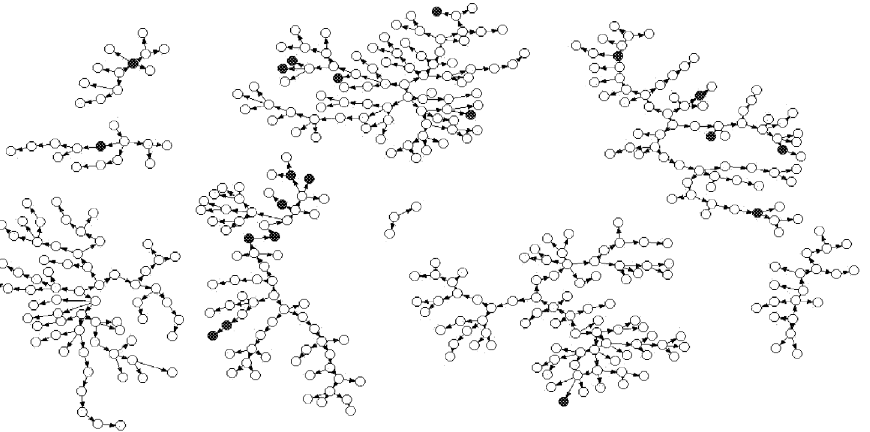
Figure 1. Respondent-driving sampling for cross-recruitment of MSM. Black circles represent HIV-positive and white circles represent HIV- negative participants. One seed that did not recruit any other participants and was dropped from this figure.